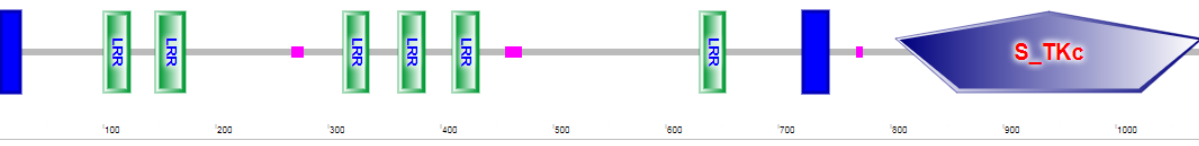
Figure 3. Secondary structure of BAK1. LRR: leucine-rich repeats motif; S_TKc: Tyrosine kinase, catalytic